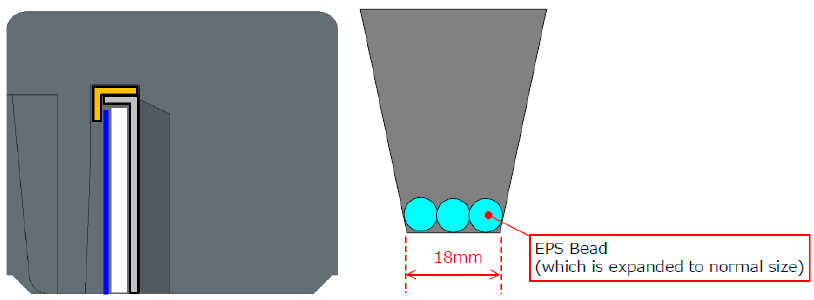
Figure 25. Multi-size application for EPS cushion